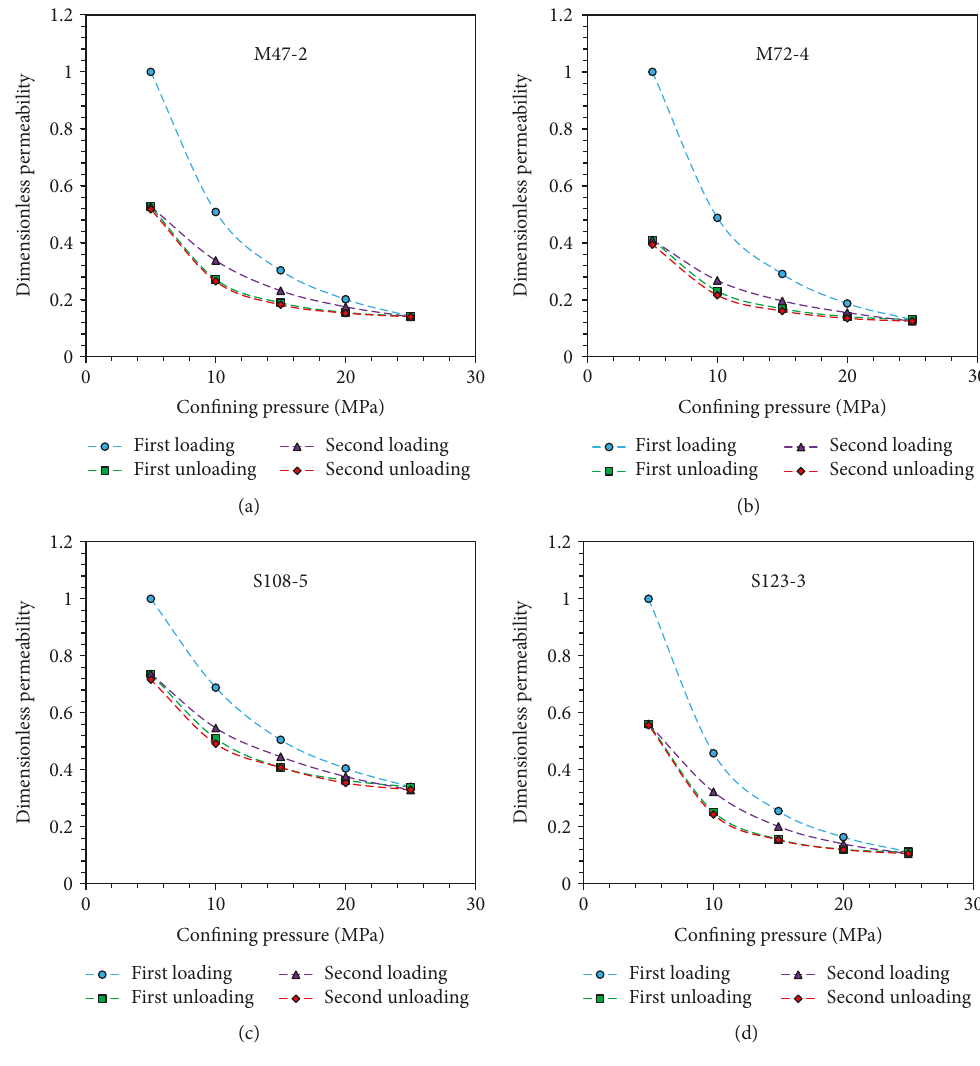
Figure 11: Stress sensitivity of Taiyuan